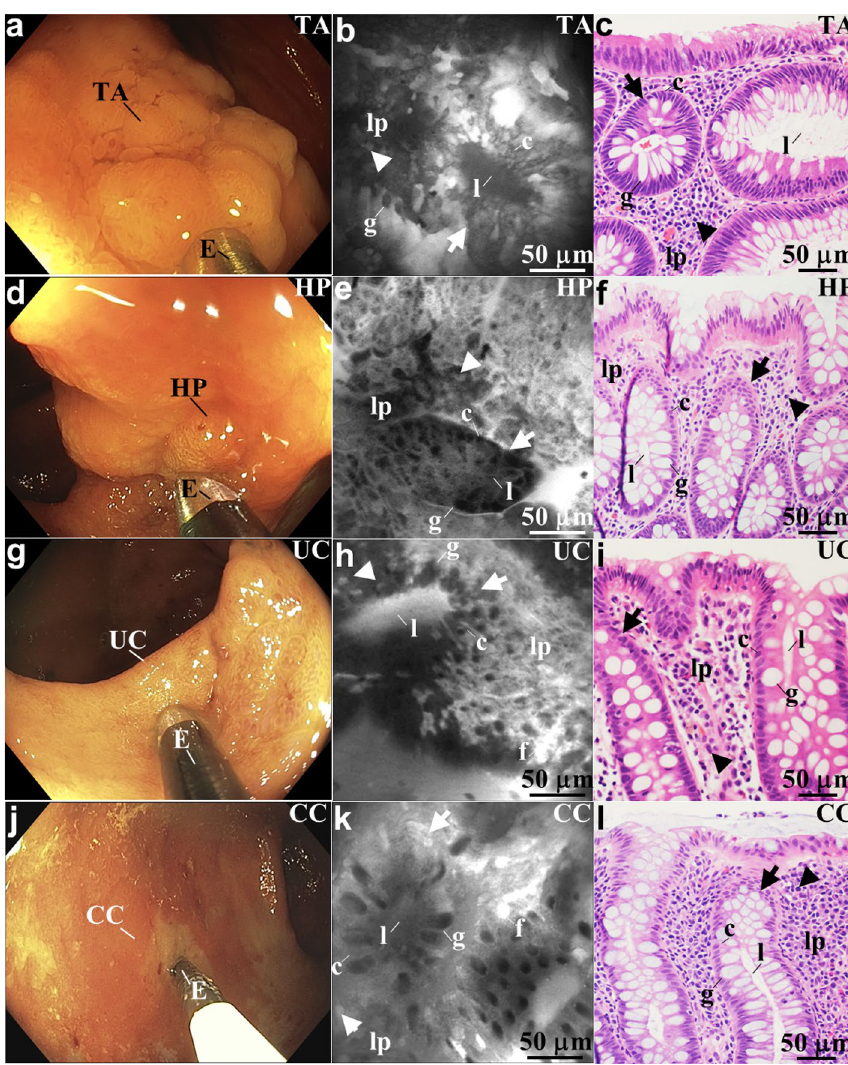
Figure 4. In vivo images of colonic mucosa. Representative white light endoscopy, confocal endomicroscope, and histology (H&E) images are shown for ( a-c ) adenoma, ( d-f ) hyperplastic polyp, ( g-i ) ulcerative colitis, and ( j-l ) Crohn’s colitis. ( b ) Confocal image collected with the endomicroscope (E) in vivo from a tubular adenoma (TA) is shown. This pre-malignant lesion shows a loss of normal crypt (arrow) architecture, distorted crypt lumens (l), and crowded lamina propria (lp). Colonocytes (c), goblet cells (g), and inflammatory cells (arrowhead) can also be identified. See Supplementary Video 2. ( e ) Confocal image collected in vivo from a hyperplastic polyp (HP) is shown. This benign lesion shows a stellate crypt (arrow) structure, slit-shaped crypt lumens (l), and irregular lamina propria (lp). Colonocytes (c), few goblet cells (g), and inflammatory cells (arrowhead) can also be identified. See Supplementary Video 3. ( h ) Confocal image collected in vivo from ulcerative colitis (UC) is shown. This inflammatory condition shows distorted crypt (arrows) architecture with prominent goblet cells (g). Fluorescein (f) plumes extrude from the epithelium reflecting increased vascular permeability. Plenty of inflammatory cells (arrowheads) can be seen in the lamina propria (lp). See Supplementary Video 4. ( k ) Confocal image collected in vivo from patchy areas of Crohn’s colitis (CC) is shown. This inflammatory condition shows distorted crypt (arrows) architecture with prominent goblet cells (g). Fluorescein (f) plumes extrude from the epithelium reflecting increased vascular permeability. Plenty of inflammatory cells (arrowheads) can be seen in the lamina propria (lp). See Supplementary Video 5. ( b, e, h, k ) Images were processed using LabVIEW